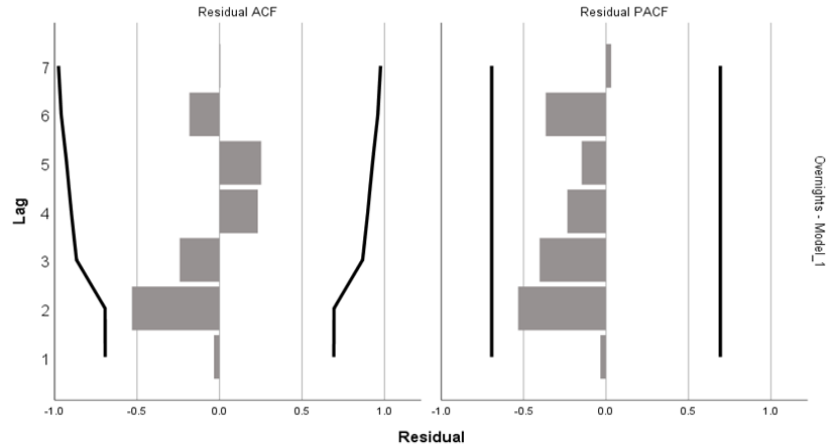
Figure 11. Residual ACF and PACF.